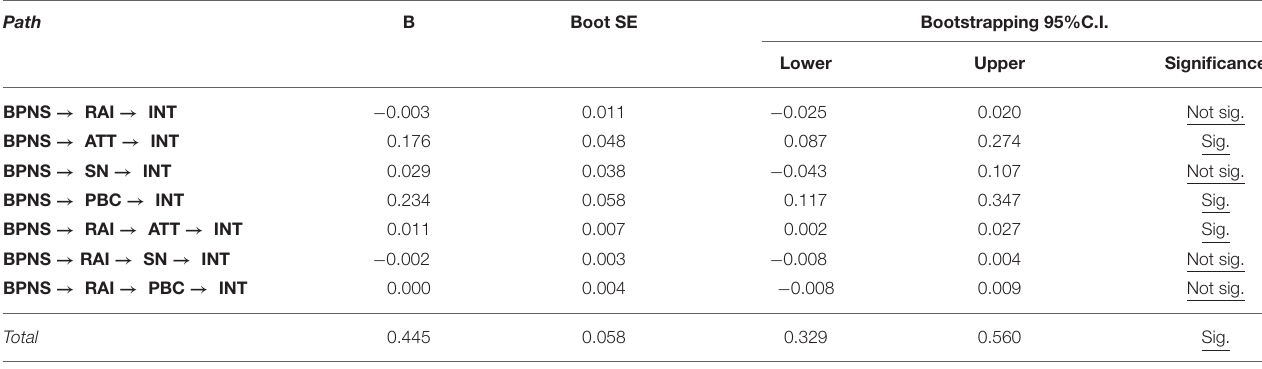
TABLE 4 | Path coefficients of indirect effects for mediation model. Path B Boot SE Bootstrapping 95%C.I.